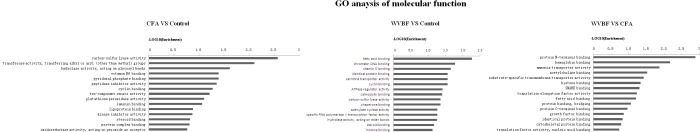
Gene ontology (GO) classification based on molecular function considering the differential gene expression using parameters, P-value < 0.05 and FDR < 0.05 to filter explicit results.